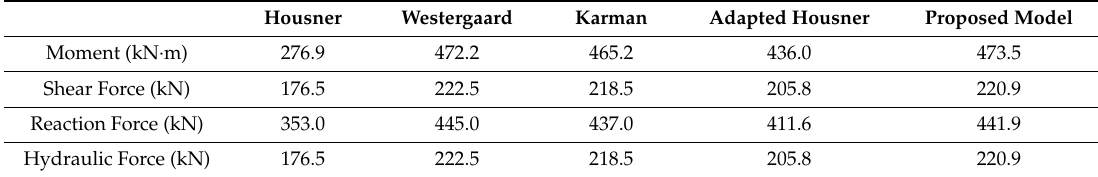
Table 9. Comparison of member force from each